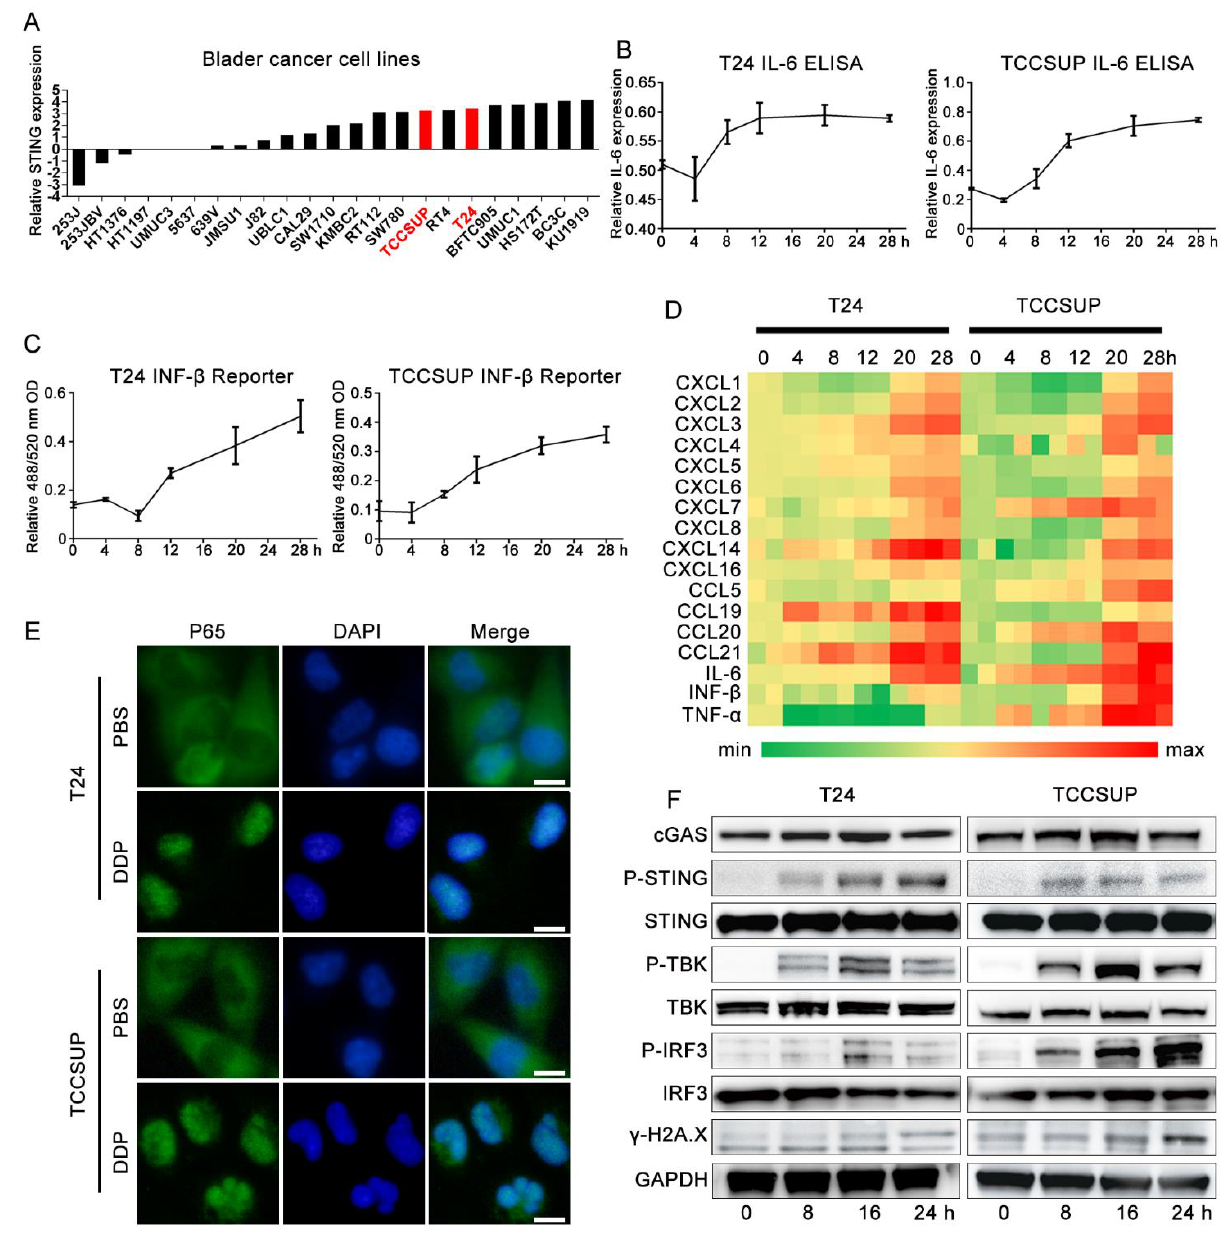
Figure 2. Immune effect of cisplatin in bladder cancer is related to the activation of cGASSTING pathway. ( A ) Basic transcription levels of STING in bladder cancer cell line on CCLE database. ( B – D ) T24 and TCCSUP cell lines were treated with 2 µ g/mL cisplatin for 0 h (control group), 4 h, 8 h, 12 h, 20 h, 28 h at standard condition, respectively. ( B ) ELISA analysis of IL-6 secretion in supernatants in cisplatin treated T24 and TCCSUP cell lines and corresponding control groups for different time points. ( C ) IFN Bio-assay in cisplatin treated T24 and TCCSUP cell lines and corresponding control groups for different time points. ( D ) qRT-PCR analysis of cytokines and chemokines expression in cisplatin treated T24 and TCCSUP cell lines and corresponding control groups for different time points. Shown are genes induced at least two repeats. ( E ) Immunofluorescence assay showed subcellular distribution of p65 in T24 and TCCSUP cell lines treated with 2 µ g/mL cisplatin or PBS for 24 h. Scale bar represent 5 µ m. ( F ) Western blotting results of key proteins involved in cGAS-STING pathway in T24 and TCCSUP cell lines treated with 2 µ g/mL cisplatin for 0 h, 4 h, 8 h, 12 h, 24 h, respectively. GAPDH was used as control protein.